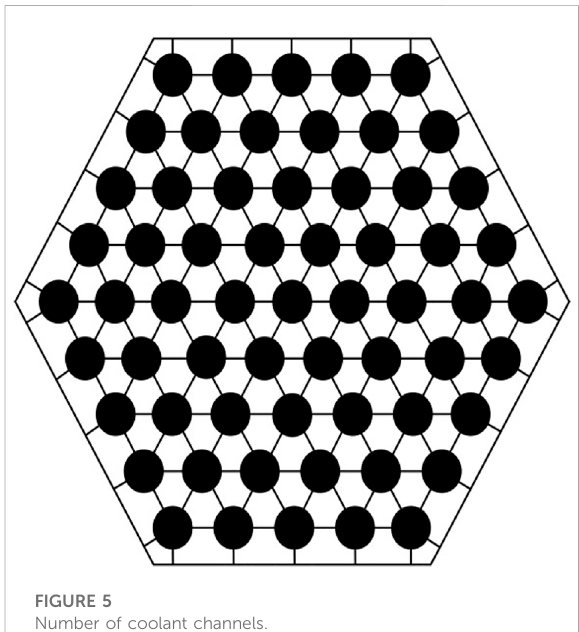
FIGURE 5 Number of coolant